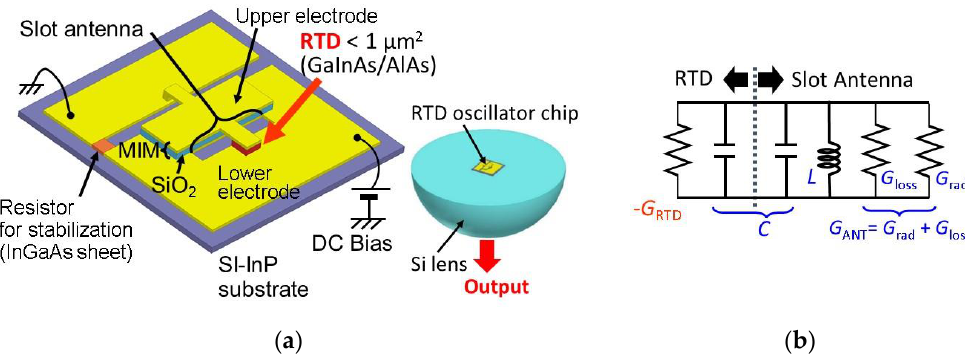
Figure 3. Structure and operating principle of RTD oscillators. Reprinted with permission from [56]. Copyright (2016) Springer Nature: ( a ) RTD oscillator integrated with slot antenna and entire structure including silicon hemispherical lens, and ( b ) equivalent circuit, including RTD and slot antenna. Parasitic elements in RTD are neglected for sake of simplicity.